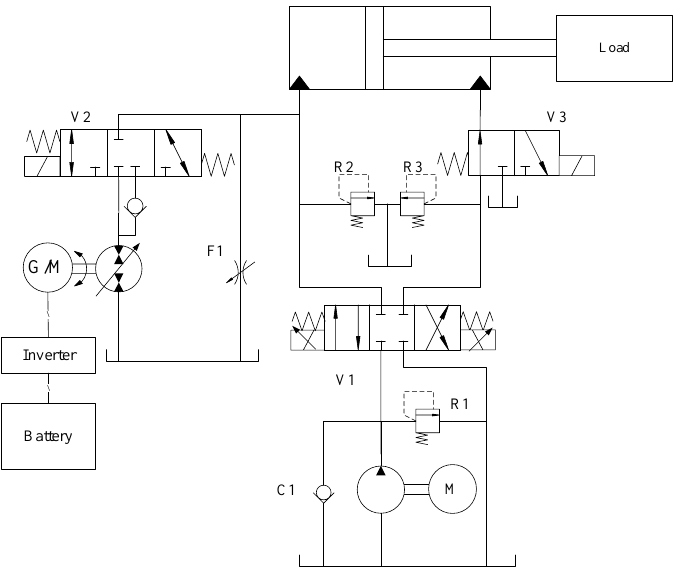
Figure 2. Hydraulic circuit of the proposed system.